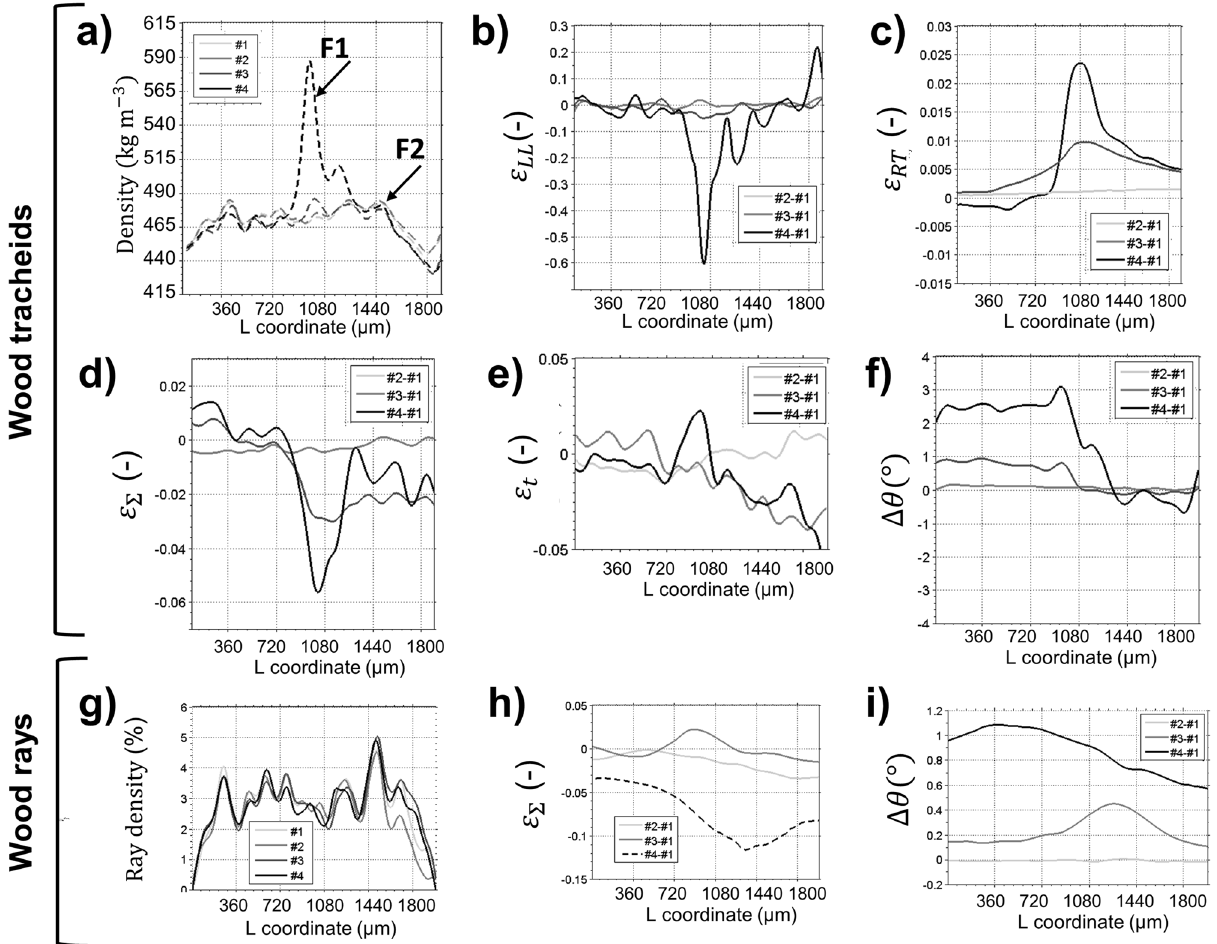
Figure 8. Average deformation profiles along grain direction for L-sample of Fig. 6. ( a – f ) are computed with ICT of tracheids, ( g – i ) with ICT of wood rays. Macroscopic strains ε LL , ε RT and geometric cell deformations (cell lumen area ε � , cell wall thickness ε t , cell inclination �θ ) are shown. Strong densification effects are observed for wood tracheids concentrated in fracture lines F1 and F2, while wood rays show more distributed deformation patterns. ε � , ε RT and �θ provide clear indications for the onset of plastic deformation (#3),